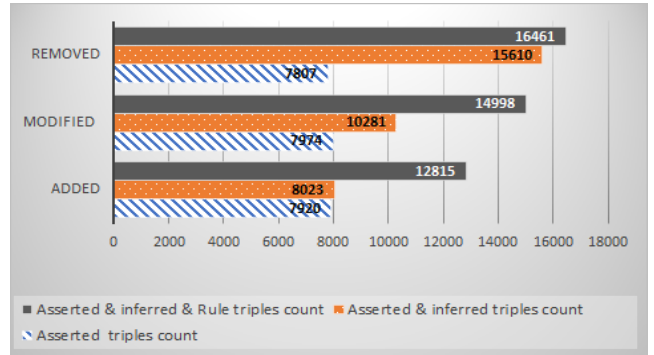
Figure 8. Amount of triples (asserted and inferred) affected by the